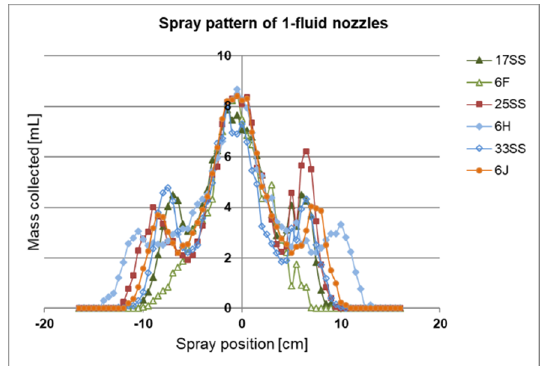
Figure 8. 1-Fluid-nozzles spraying pattern. The spraying pattern along the y-axis was measured with a spray collector. The x-axis shows the mass distribution of the spray collected in at least 66 testing tubes at different positions. The pressure was set to p ( L ) = 2.5 bar with a distance of d ( NS ) = 17.5 cm. The humidity was 44%, and room temperature was 21.6 °C.